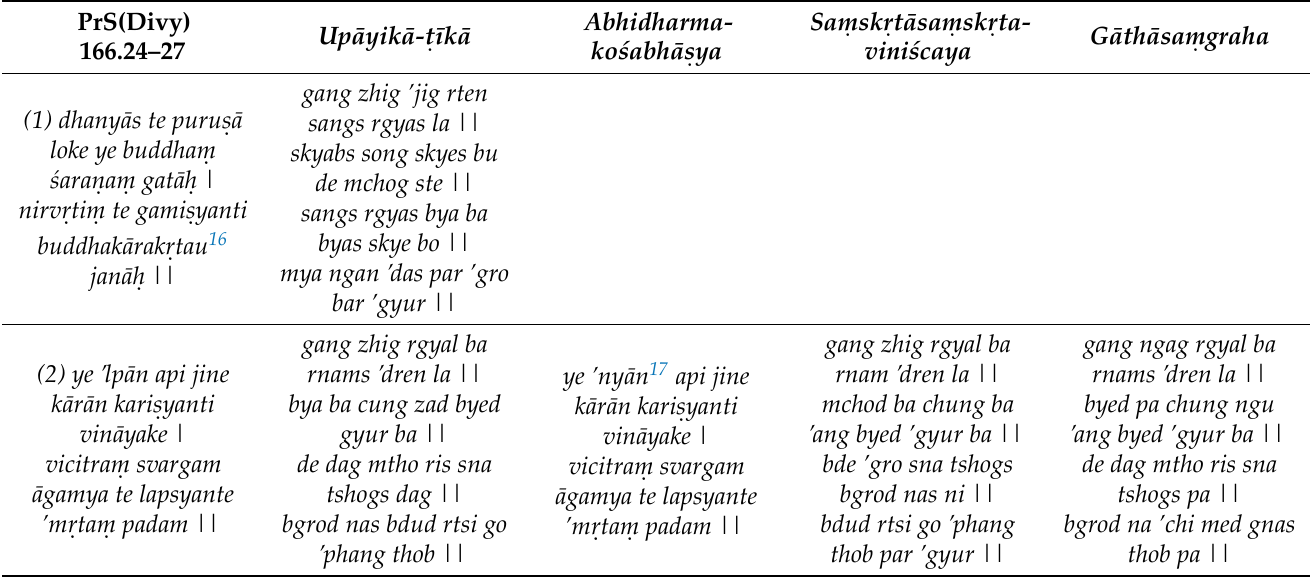
Table 2. The fourth verse sermon that was spoken by the Buddha and its parallels in other